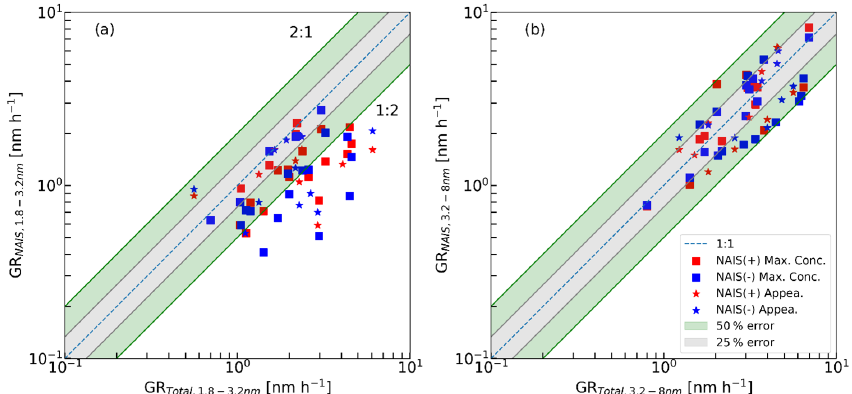
Figure 1. Comparison of the apparent (maximum concentration, square symbols, and appearance time method, star symbols) ion GRs (GR NAIS ) and the total GRs (neutral plus charged, GR Total measured with a DMA-train) for the dataset recorded between March– September 2020 in Hyytiälä. The dashed blue line shows the 1:1 ratio and the colored areas the 25% (grey) and 50% (green) deviation regions. Panel (a) compares the sub-3nm size range (1.8–3.2nm) and (b) the 3.2–8nm size range. Red symbols correspond to the measure- ment of the positive ion growth rate, and blue symbols correspond to the measurement of the negative ion growth